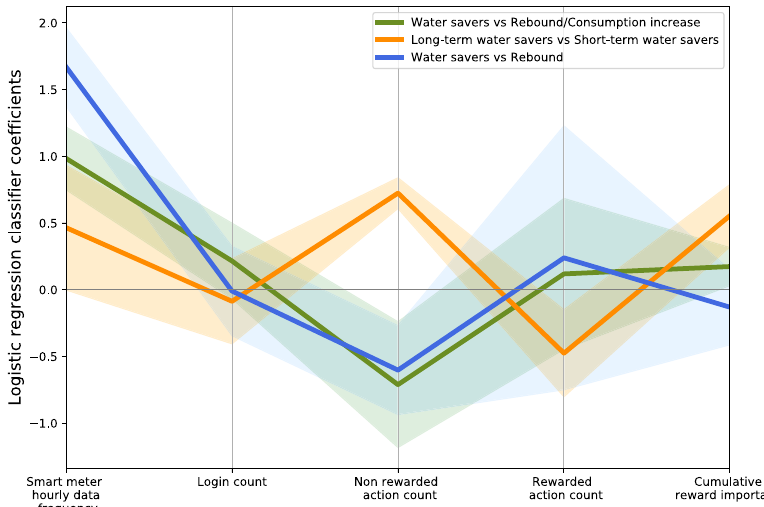
Fig. 4 In fl uence of smart meter data frequency and level of engagement with the digital SmartH2O application on household behavior change patterns. The coef fi cients of a logistic regression classi fi er weighting fi ve normalized independent variables, i.e., smart meter hourly data frequency (binary variable for hourly vs. daily data), login count, non-rewarded action count, rewarded action count, and cumulative reward importance, are reported for three different tests. The fi rst test (green line) classi fi es water savers against rebound or consumption increase households. The second test (orange line) classi fi es long-term water savers against short-term water savers . The third test (blue line) classi fi es water savers against rebound households. The different household clusters are characterized in Fig. 3. The shaded area around each line is de fi ned by the standard